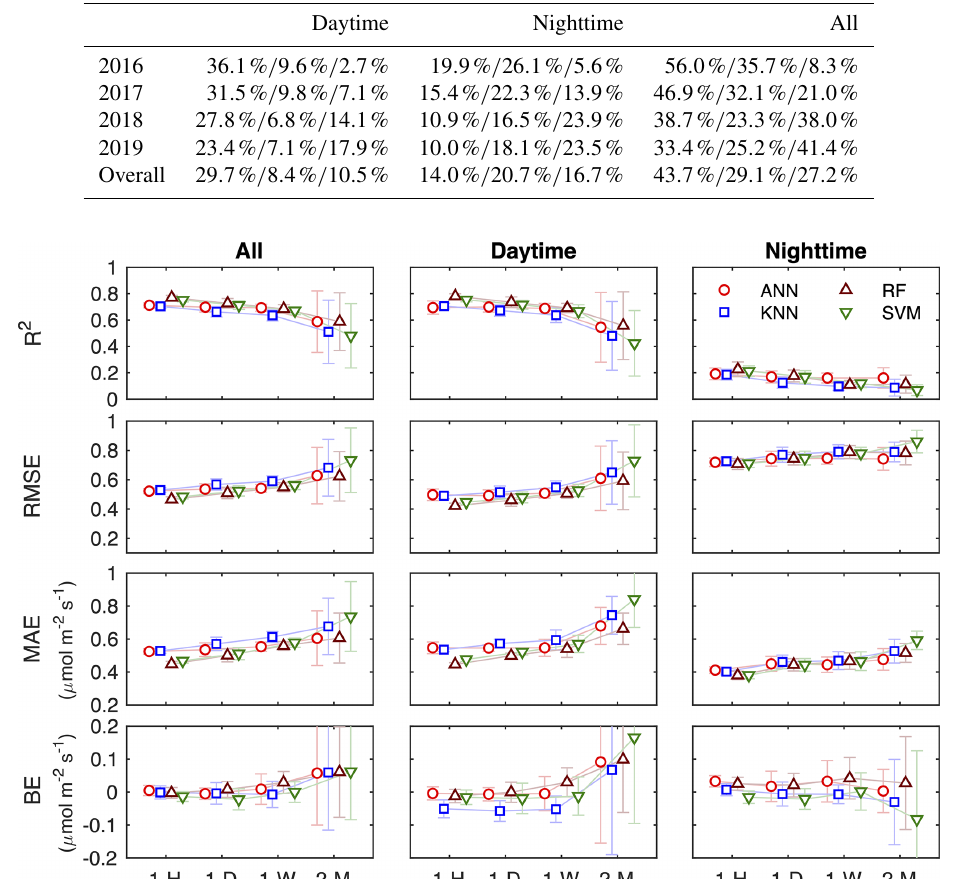
Figure 3. Performance of NEE gap-filling algorithms for the four gap length scenarios (i.e., 1h (1-H), 1d (1-D), 1 week (1-W), and 2 months